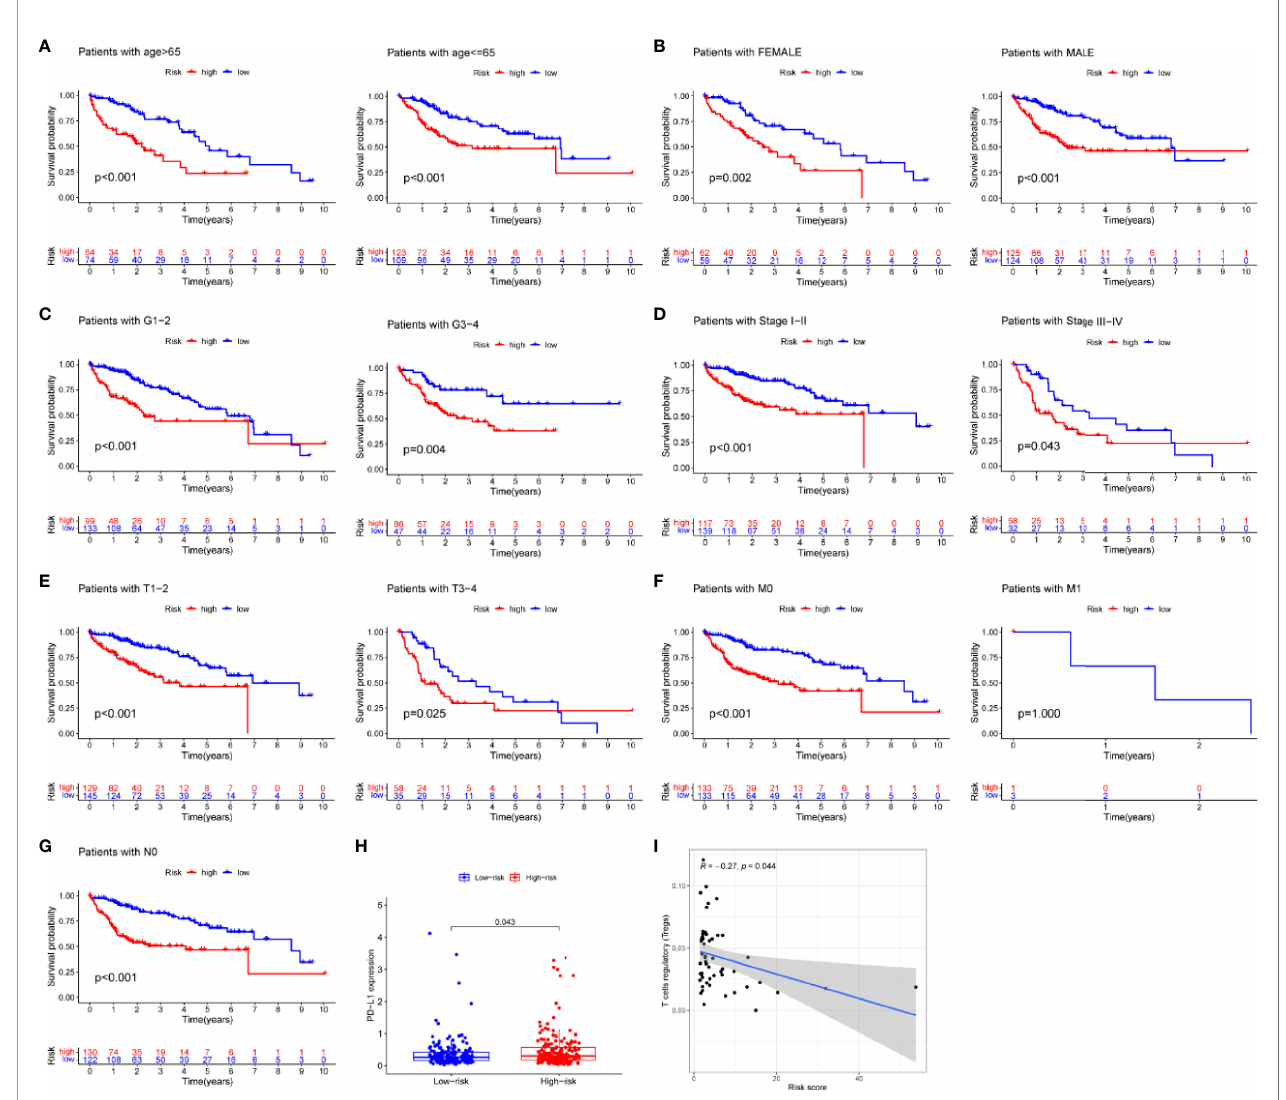
FIGURE 7 | Survival analysis, box plots and correlation plots of clinical factors. (A – G) Survival analysis by age, gender, grade, stage, tumor and metastasis and node, respectively, (H) Box plot of PD-L1 expression by risk groups, (I) Correlation plot between regulatory T cells and risk